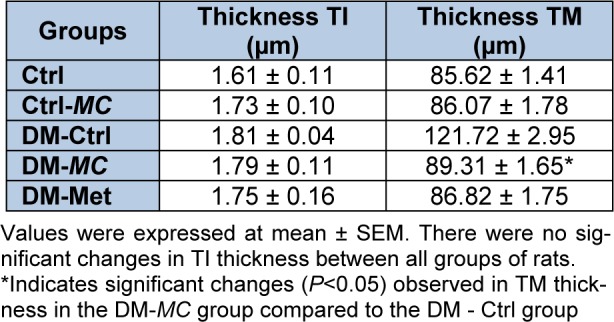
Effect of MC fruit extract on thickness of Tunica Intima (TI) and Tunica Media (TM) in the aortic tissues